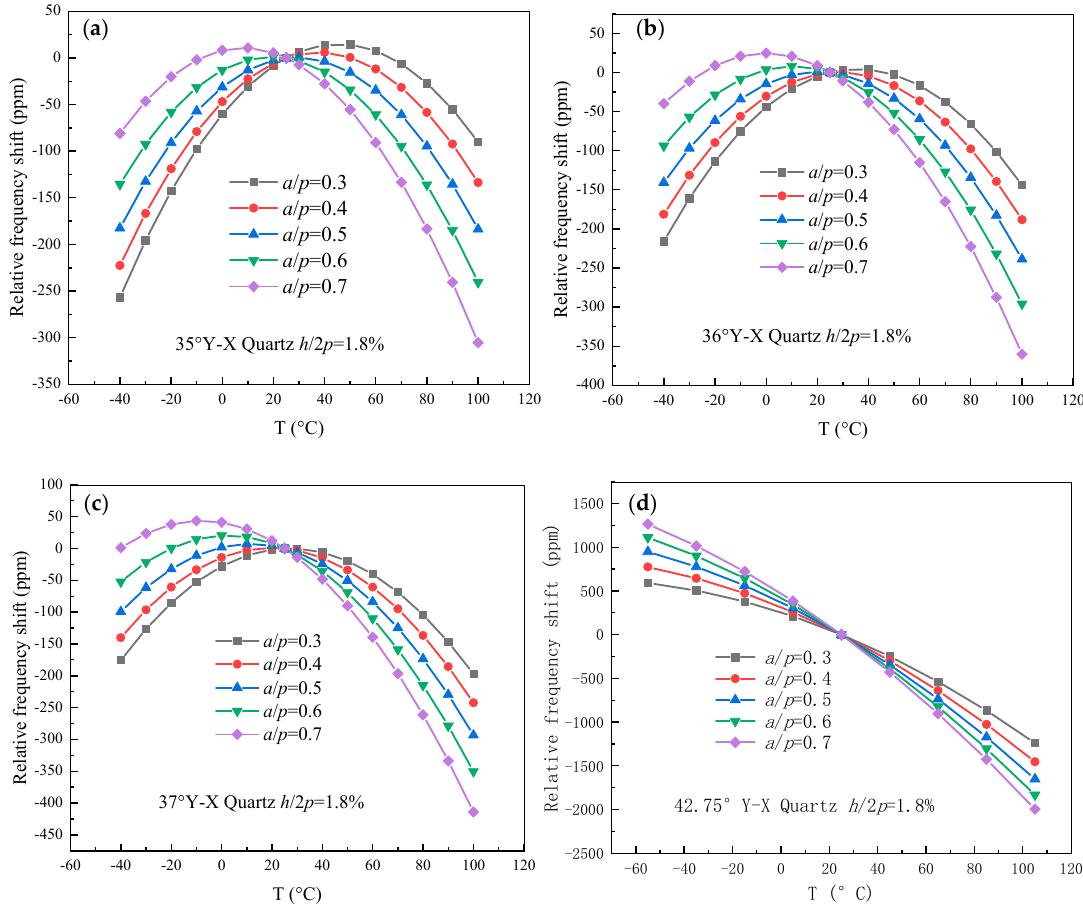
Figure 2. The relative frequency shift of quartz with different metallization ratios. ( a ) 35.0° Y-X quartz; ( b ) 36.0° Y-X quartz; ( c ) 37.0° Y-X quartz; ( d ) 42.75° Y-X quartz.